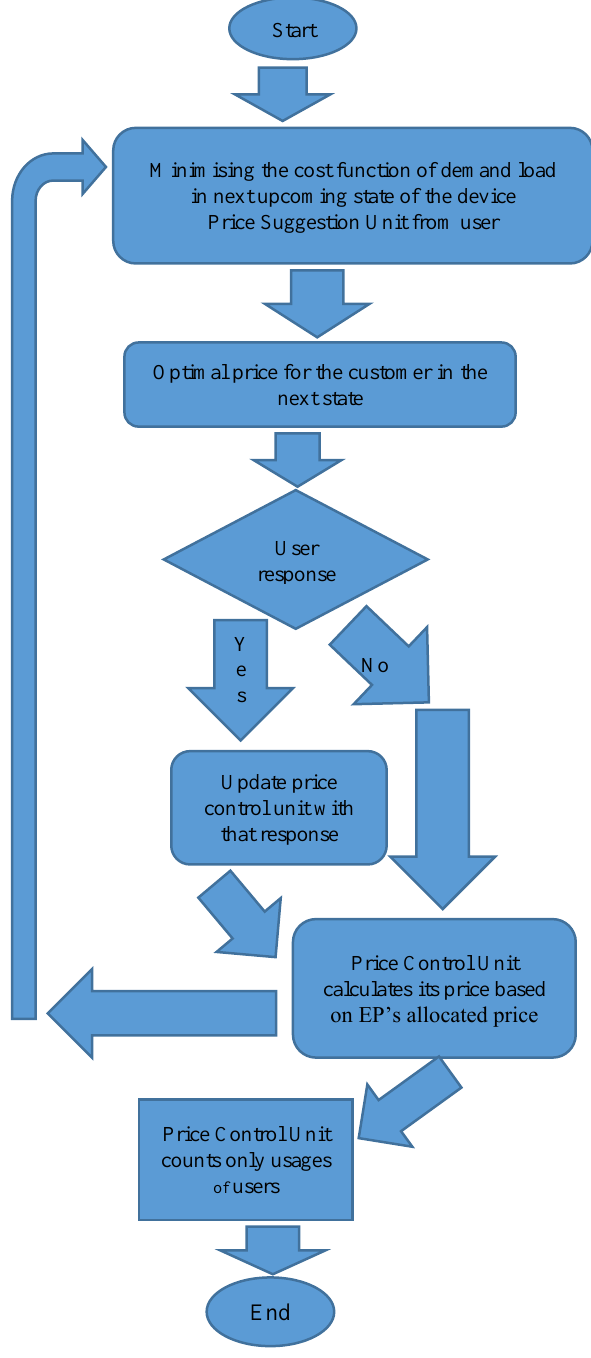
Figure 2. Proposed pricing model working